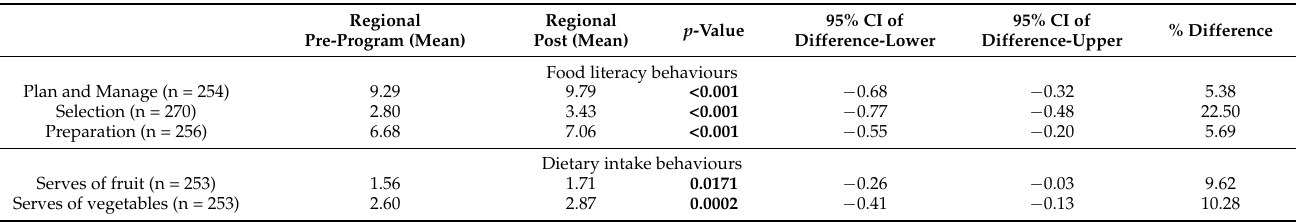
Table 6. Paired t-tests comparing regional pre- and post-program scores for the three food literacy behaviour domains and change in self-reported dietary intake of fruits and vegetables.